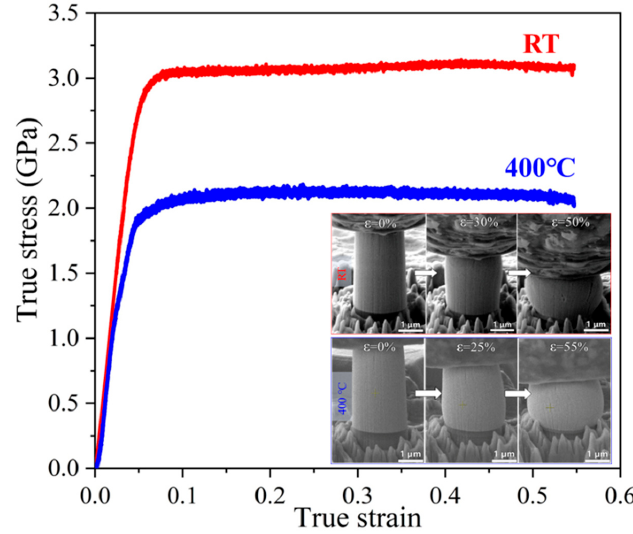
Figure 13. In situ micropillar compression tests of 600 °C annealed Ni(75 at.%)-SiOC nanocomposite at RT and 400 °C [60]. The insets show the corresponding SEM snapshot image micropillars at different strains.